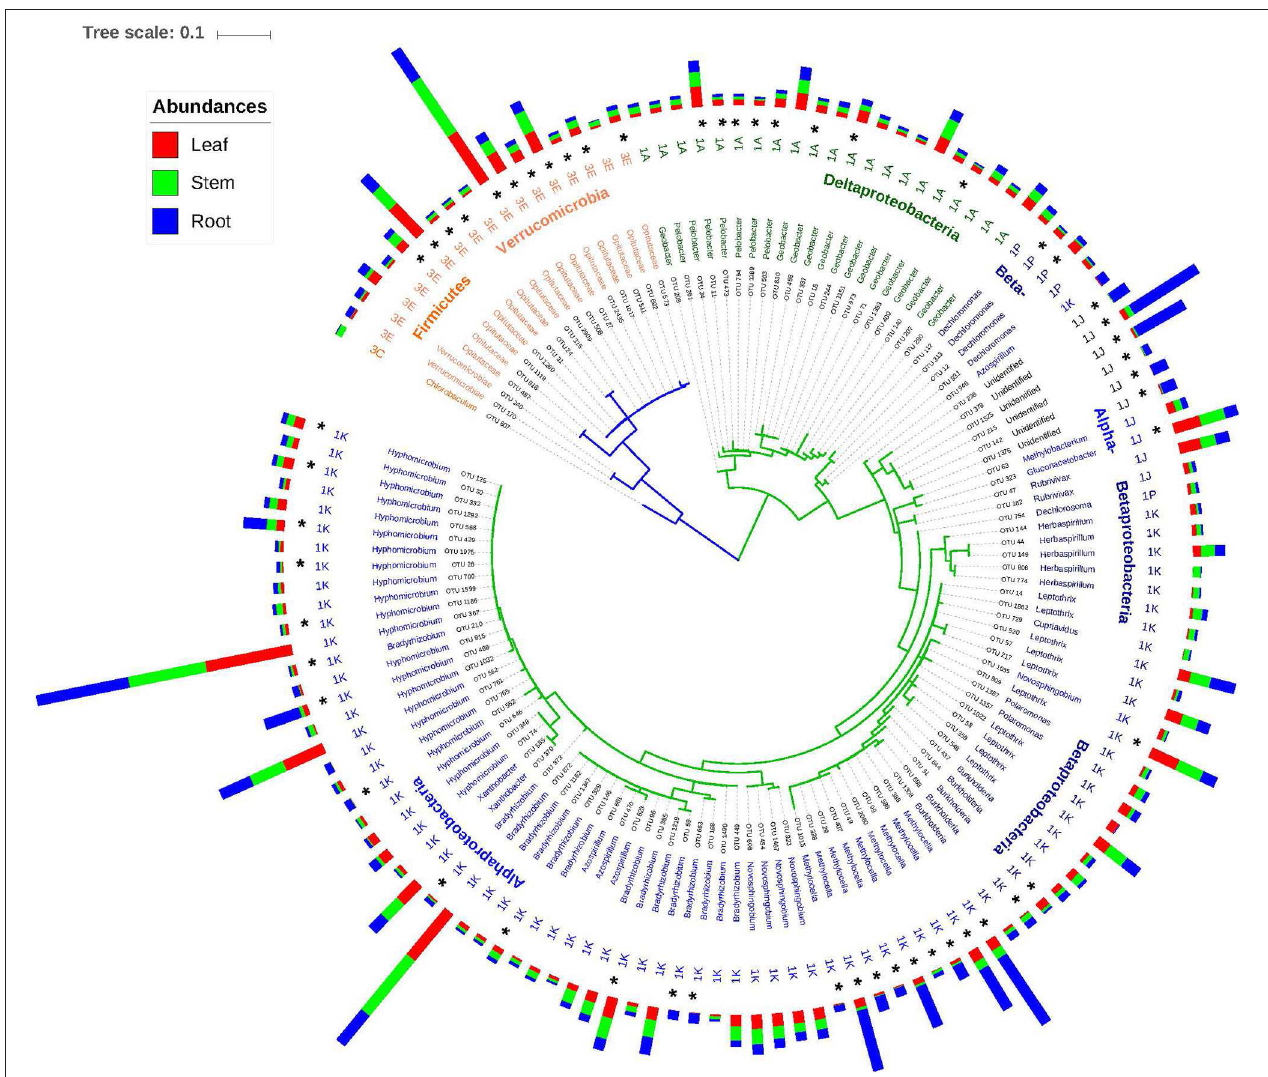
FIGURE 5 | Neighbor joining tree based on top 134 OTUs ( > 0.1%) with taxonomic, nifH cluster and the mean abundance. The outer bars represent relative abundances for each OTU in the different plant part